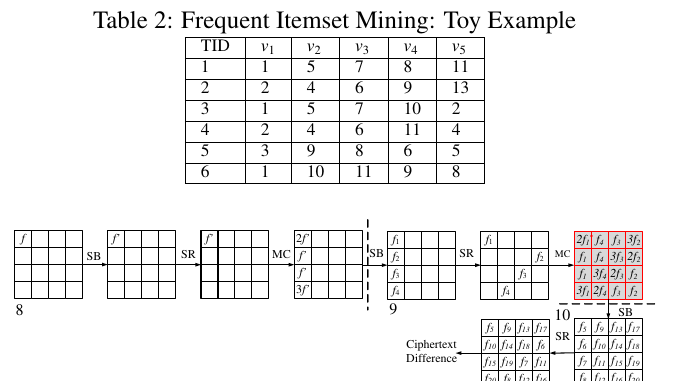
Figure 2: Fault propagation in AES with the fault injected at the beginning of 8-th round. Distin- guisher is formed at the input of the 10-th round S-Box (marked in